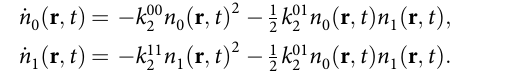
Table 1. The rate coef fi cients as a fraction of the universal rate are shown in Fig. 4, labelled by N and the total angular momentum ¼ M þ m Rb þ m Cs . This fraction is greater for projection M F N I I excited states than for the ground state, and markedly greater for N = 2. The loss from the N = 2 state is consistent with the uni- versal limit. This increase probably results from two-body inelastic collisions. However, the higher angular momentum also allows the incoming channel to couple to a larger number of NATURE COMMUNICATIONS| (2019) 10:3104